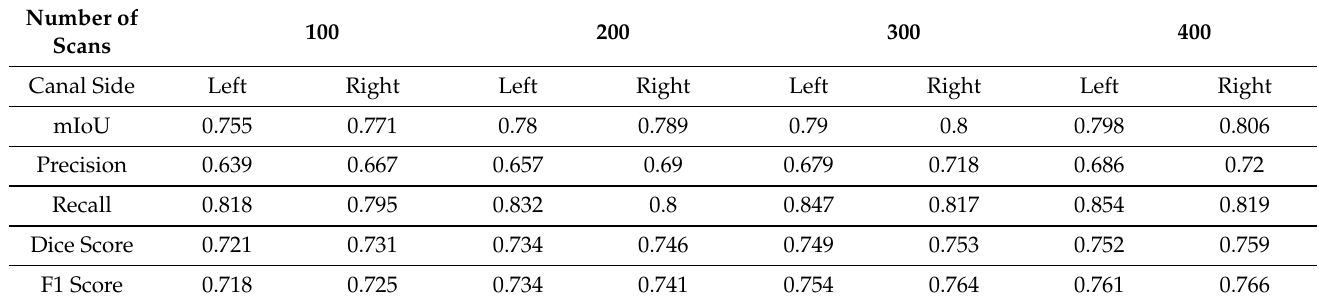
Table 4. Impact of increasing the amount of data on the performance of